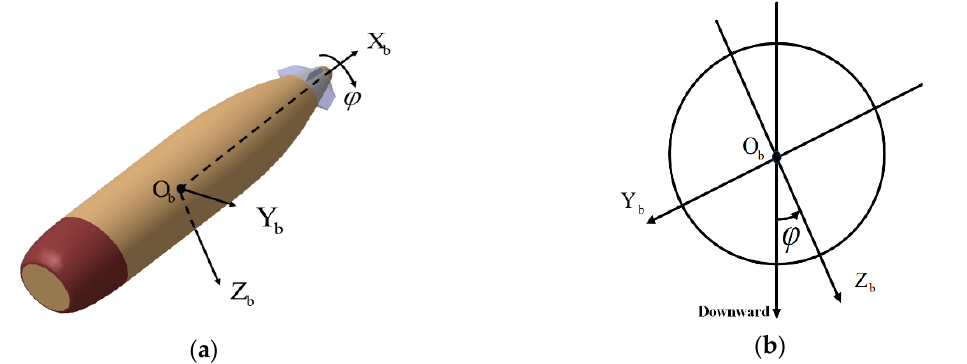
Figure 2. Here are figures to describe projectile body based on a model of 155 mm artillery projectile launched by howitzer: ( a ) Description of body coordinate system and ( b ) description of the cross-section.